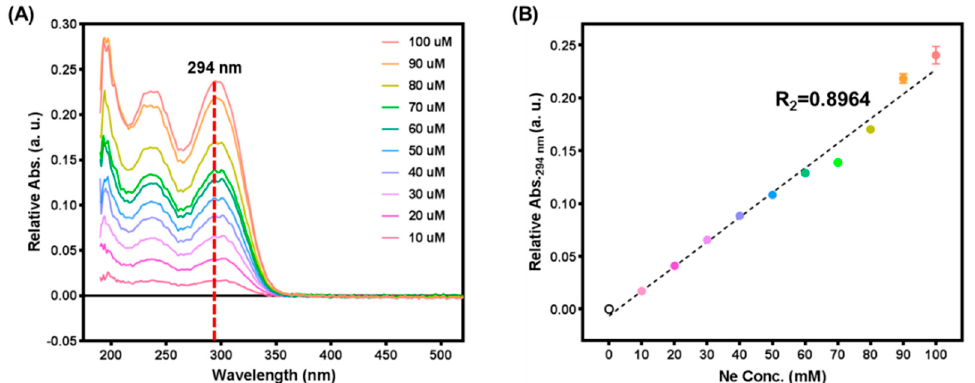
Figure 2. Stoichiometric analysis of netropsin. ( A ) UV–vis spectra of 0 to 100 µ M netropsin in aqueous solution. Netropsin showed major peaks at 245 and 294 nm, and 294 nm was selected as it did not overlap with the major peak of DNAp (260 nm). ( B ) Linear regression plot for the netropsin concentration dependence of the absorbance at 294 nm.